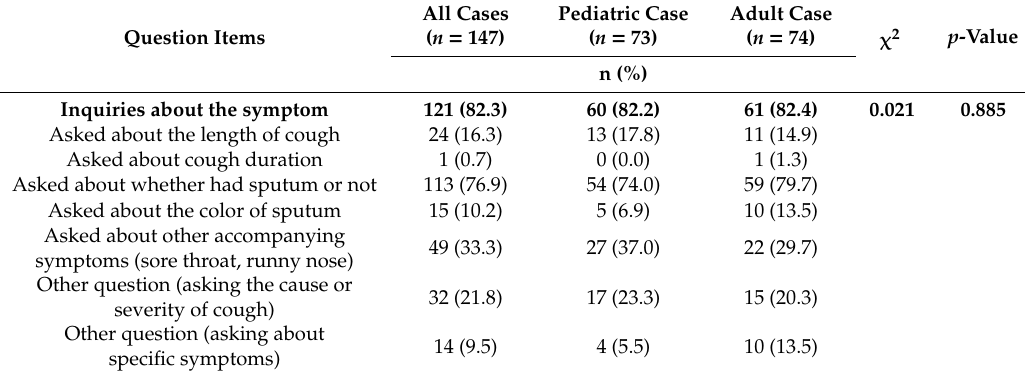
Table 2. Inquiries and counseling during community pharmacy visits in